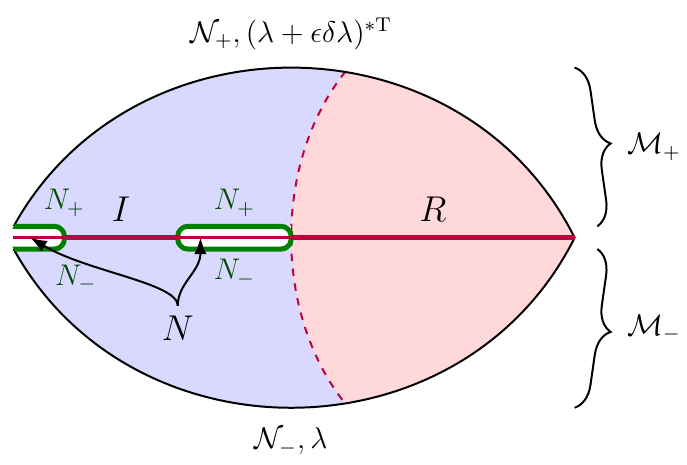
is equivalent to computing the absolute R